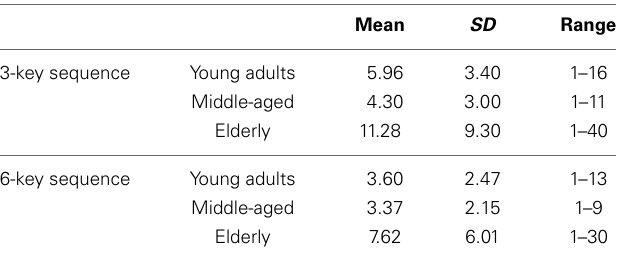
Table 1 | The mean number of cases (i.e., post-error trials) per age group for the 3-key and 6-key sequences, and their standard deviations ( SD ) and